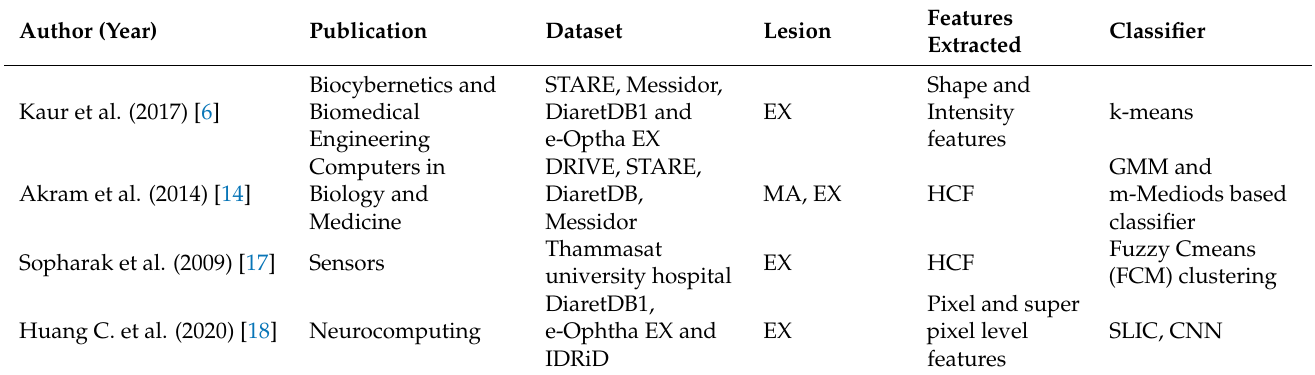
Table 7. Unsupervised machine learning styles used in the literature.